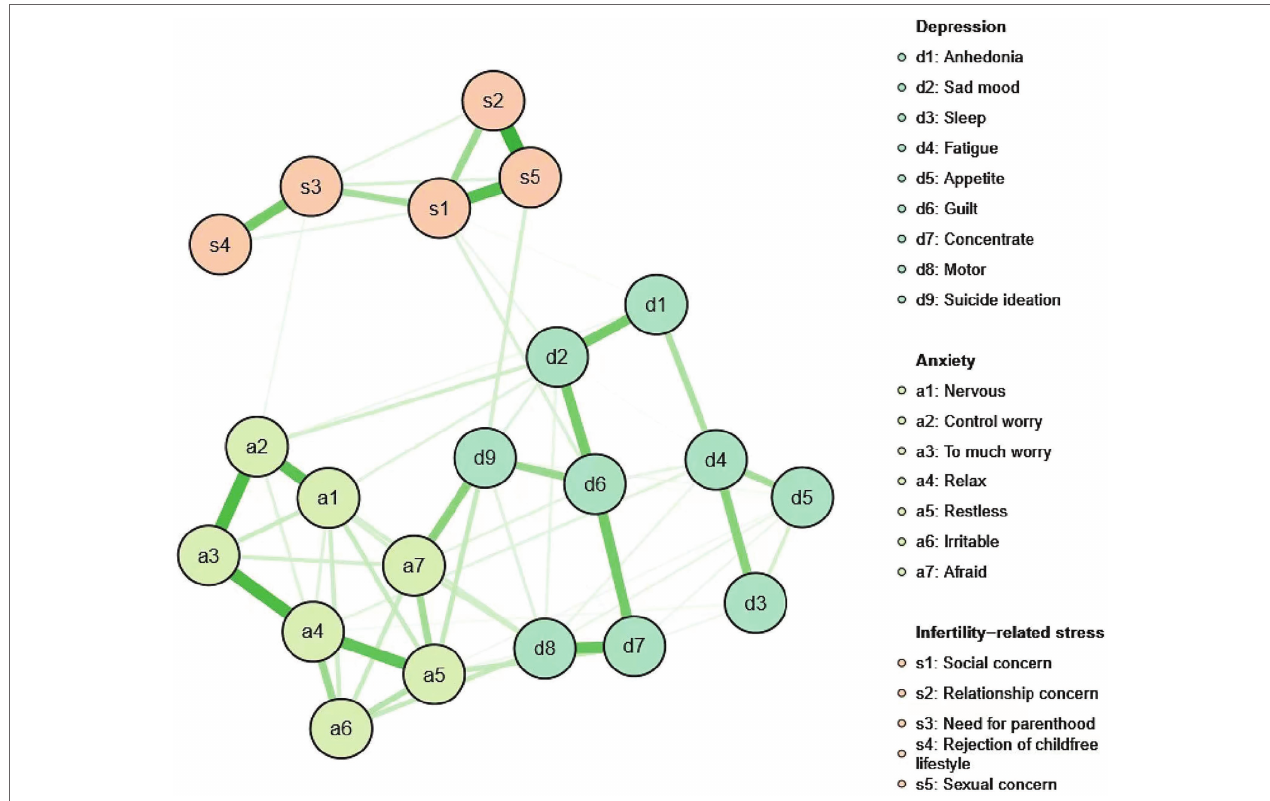
FIGURE 1 | Network containing the nine PHQ-9 depression symptoms, seven GAD-7 anxiety symptoms, and five FPI infertility-related stress symptoms. PHQ-9, Patient Health Questionnaire-9; GAD-7; Generalized Anxiety Disorder-7; and FPI, Fertility Problem